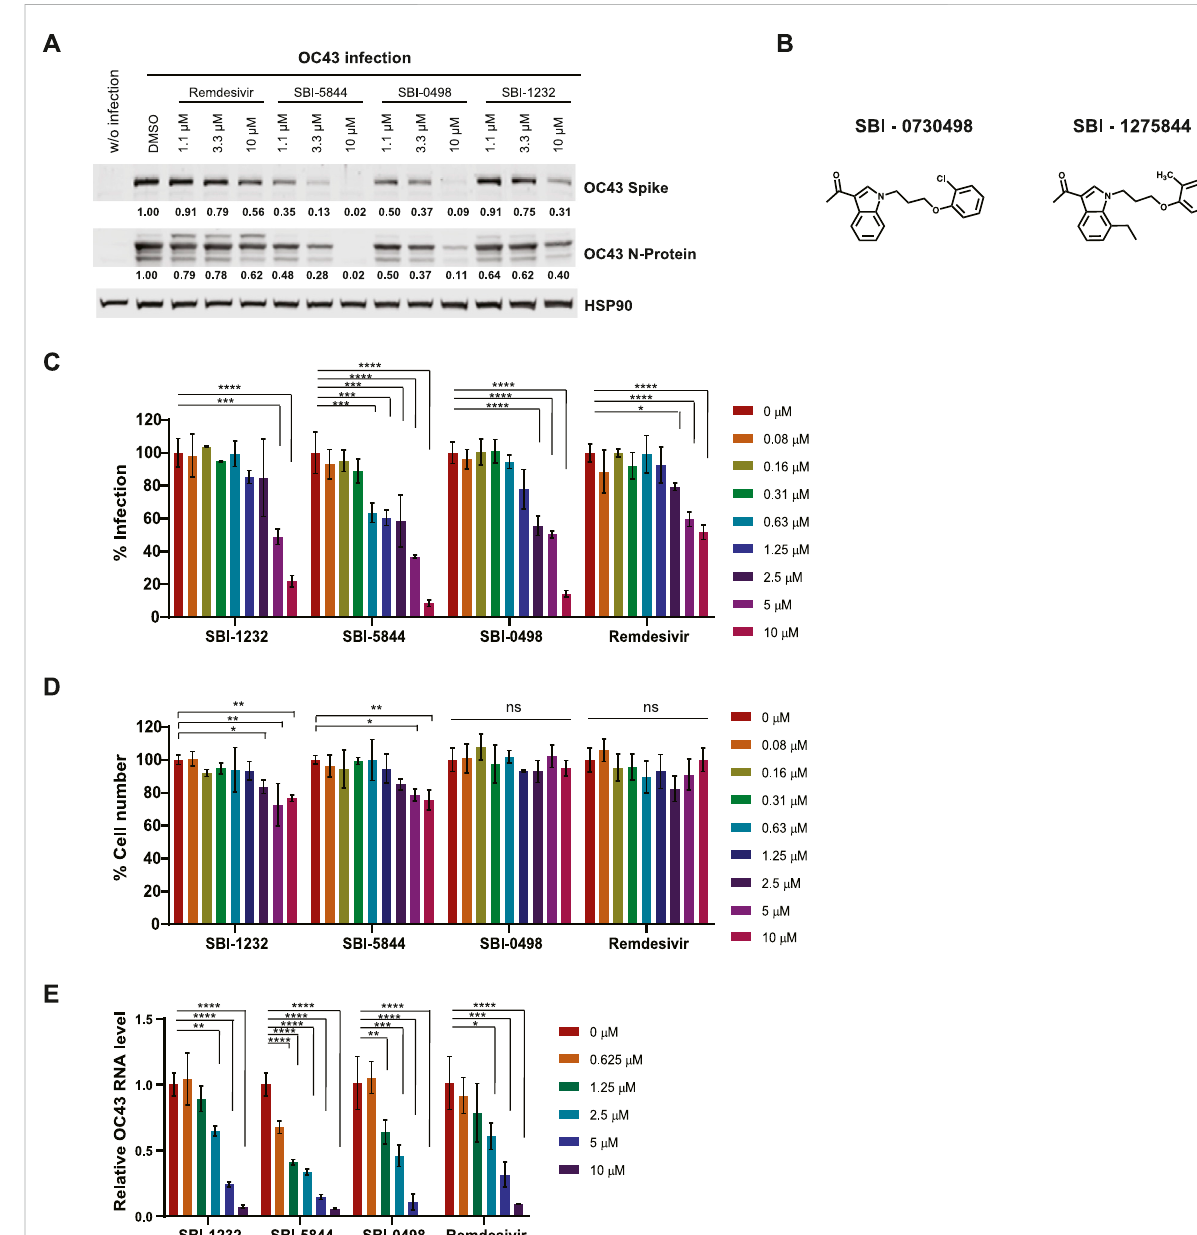
Comparison of virus replication inhibition by selected compounds. (A) Vero E6 cells were infected with OC43 and treated with indicated compounds. After 24 h, cells were lysed and subjected to Western blot analysis. Each protein band was quanti fi ed by ImageJ, normalized to HSP90 levels as indicated under the blots. (B) Chemical structures of SBI-0730498 (SBI-0498) and SBI-1275844 (SBI-5844). (C) Vero E6 cells were infectedwithOC43andtreatedwithindicatedcompounds.After48 h,cellswere fi xed,andstainedwithantibodiesagainsttheOC43N-protein and with DAPI for immuno fl uorescence imaging. Infected cells (positive stained for SARS-CoV-2 N protein) and total cells (DAPI staining) were quanti fi edusingCeligo.Foreachcondition,thepercentinfectionwascalculatedasinfectedcells/totalcellsx100,andDMSO-treatedcontrolwasset to100%infection.Datashownisthemean±SD,n=3. (D) Percentcellnumberwascalculatedasthecompound-treatedcellnumber/DMSO-treated controlcellnumberx100,withDMSO-treatedcontrolsetas100%. (E) VeroE6cellswereinfectedwithOC43andtreatedwithindicatedcompounds. After 24 h, RNA was extracted and subjected to qPCR analysis for virus RNA. OC43 RNA levels are normalized to DMSO treated control cells. Statistical analysis was performed by one-way ANOVA for the comparison of more than two groups. Data are shown as the mean ± SD, n = 3. * p ≤ 0.05, ** p ≤ 0.01, *** p ≤ 0.001, **** p ≤